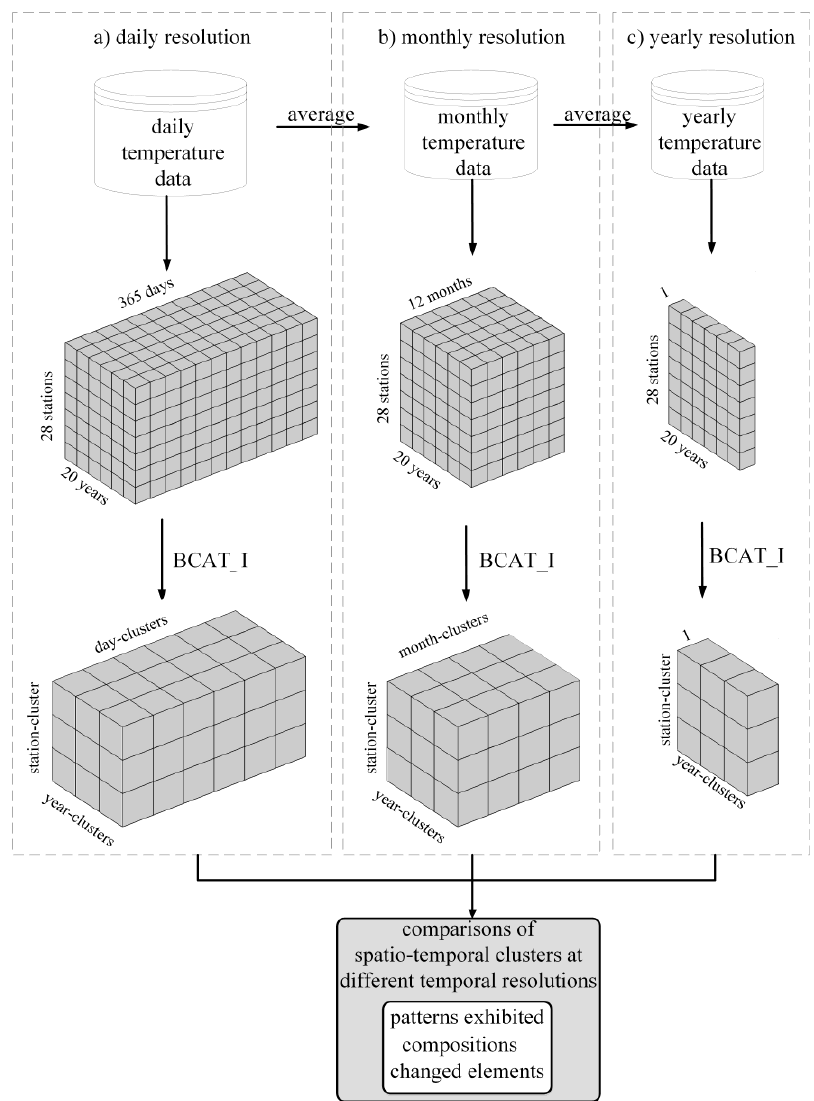
Figure 4. Workflow of tri-clustering analysis of Dutch temperature data at daily ( a ) monthly ( b ) and yearly ( c ) resolutions.